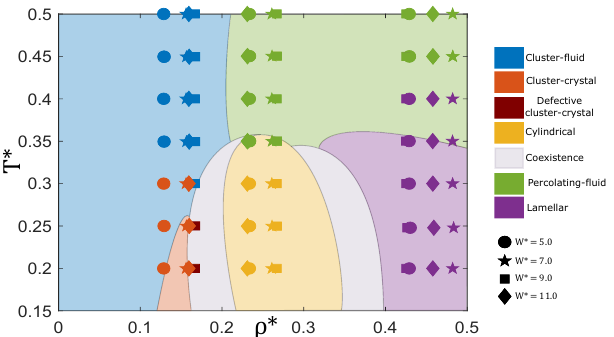
Figure 2. Sketch of the bulk phase diagram, using data from Ref. [17]. The state points studied for each pore size W ∗ = 5, 7, 9 and 11 are marked with different symbols, and their colours indicate the structure adopted by the confined fluid in each thermodynamic state, as provided in the legend.